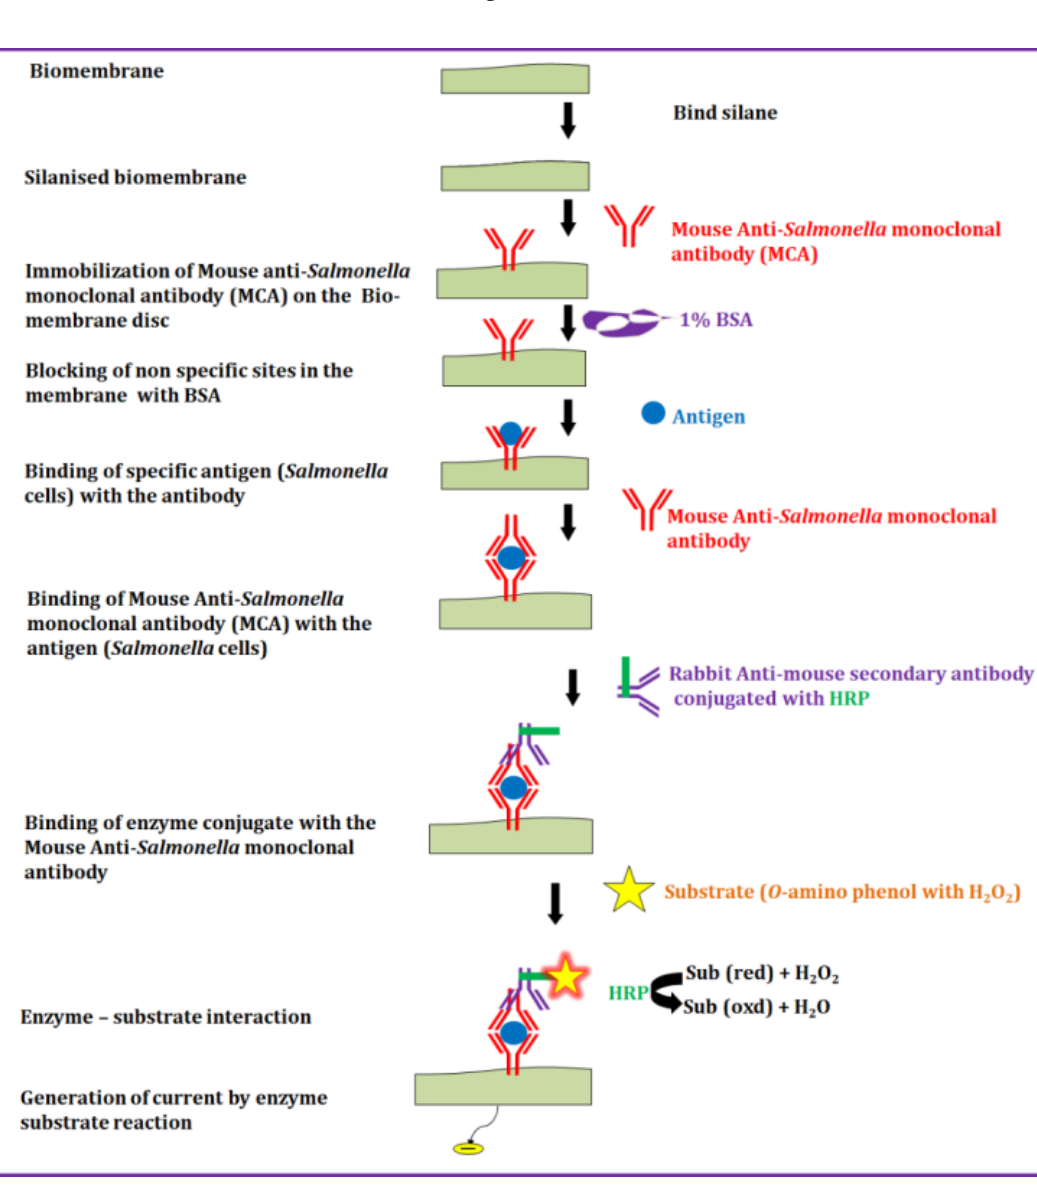
Figure 1. Fabrication of biosensor biomembrane electrode interface disc for Salmonella